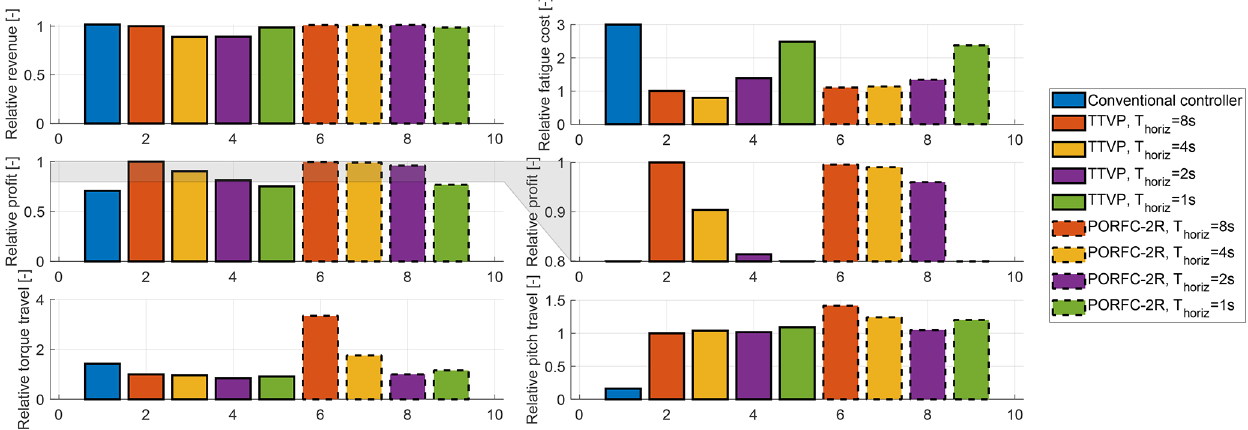
Figure 13. “Perfect prediction” scenario. Weibull-weighted KPIs for different controller formulations and prediction horizon lengths. Results are normalized with respect to the best TTVP configuration with a prediction horizon length of T horiz = 8s. Middle row, right: zoomed version of profit